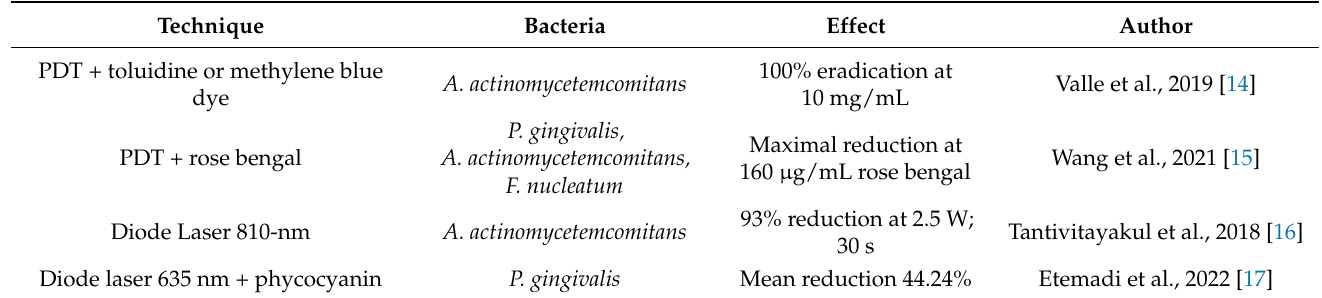
Table 1. Studies that analyze the effect of laser and photodisinfection therapy on periopathogenic bacteria in